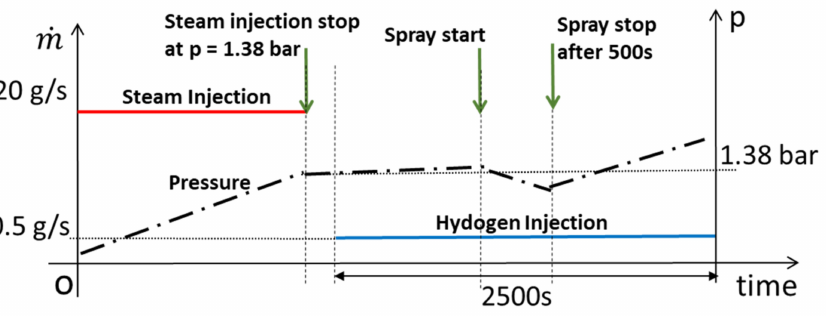
Figure 9. Schematic of the SSP4 test